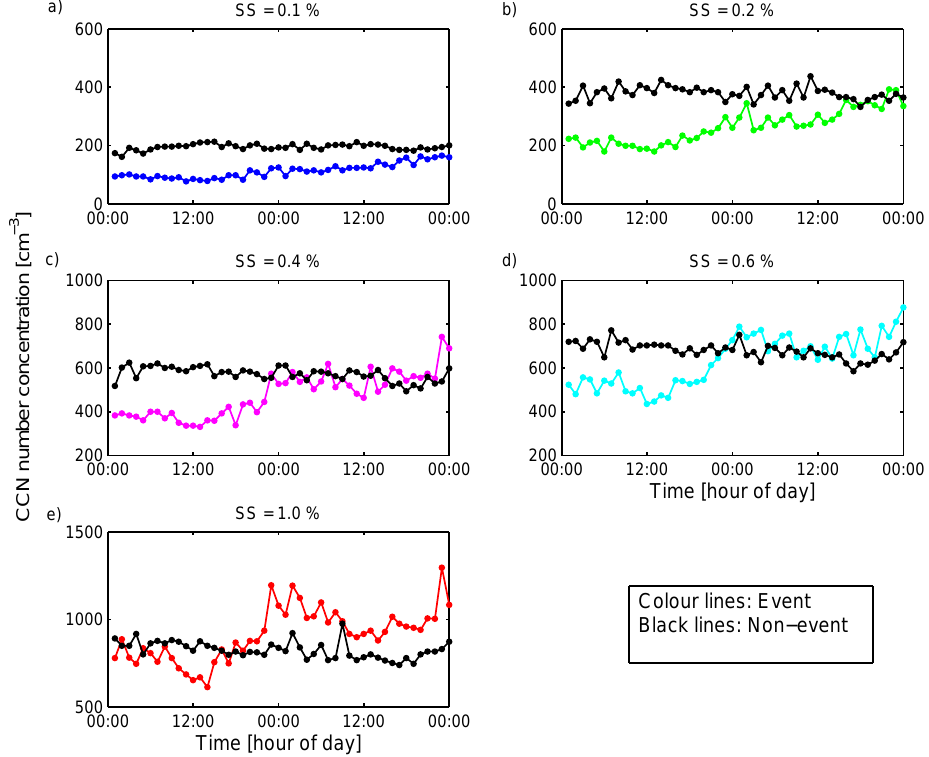
Fig. 7. Mean diurnal variation of CCN concentrations at different supersaturations (a–e) on two consecutive days, separated according to whether the first day was an event day (coloured markers) or a non-event day (black markers). The points are hourly averages over the one year data